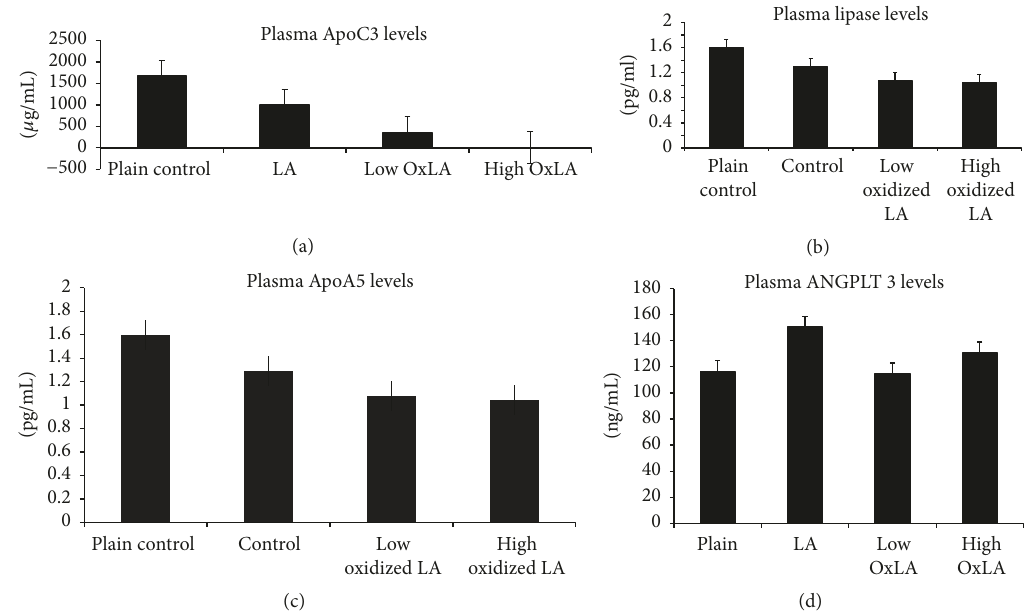
Figure 2: Plasma ApoC3 significantly decreased in a dose dependent manner in low OxLA ( 𝑃 < 0.05 ) compared to plain group. The levels were also significantly reduced ( 𝑃 < 0.05 ) between low OxLA and LA. Plasma ApoC3 levels were also significantly reduced ( 𝑃 < 0.01 ) in higher OxLA group compared to the LA. (b) Oxidized linoleic acid supplementation led to dose dependent significant ( 𝑃 < 0.05 ) decreases in plasma hepatic lipase when compared to the plain fed group of mice. The decreases in the hepatic lipase levels in the LA control group compared to the plain mice were not significant. (c) Plasma ApoA5 levels decreased but nonsignificantly in the treated groups compared to the plain control. (d) ANGPTL3 concentration decreased among the OxLA fed groups compared to the LA control linoleic acid group; interestingly the experimental groups had either similar or slightly elevated ANGPTL3 concentration compared to the plain